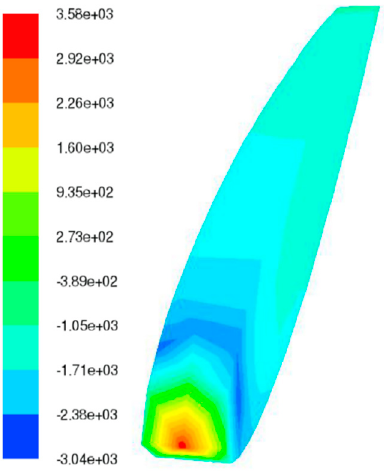
Figure 3. Model of blade pressure.